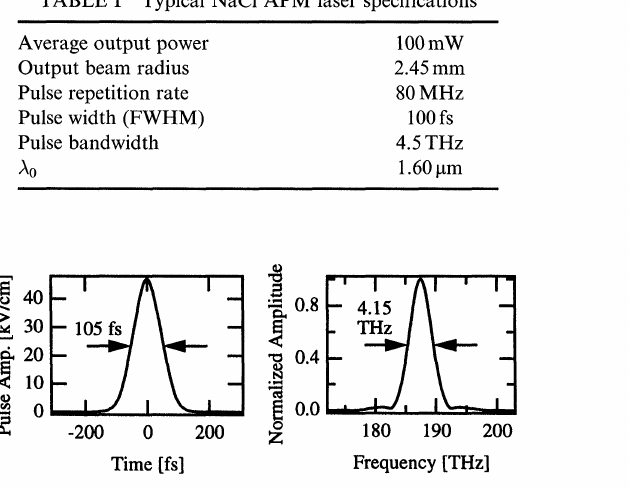
FIGURE 3 Steady-state output pulsewidth and spectrum of the APM model for a typical set of